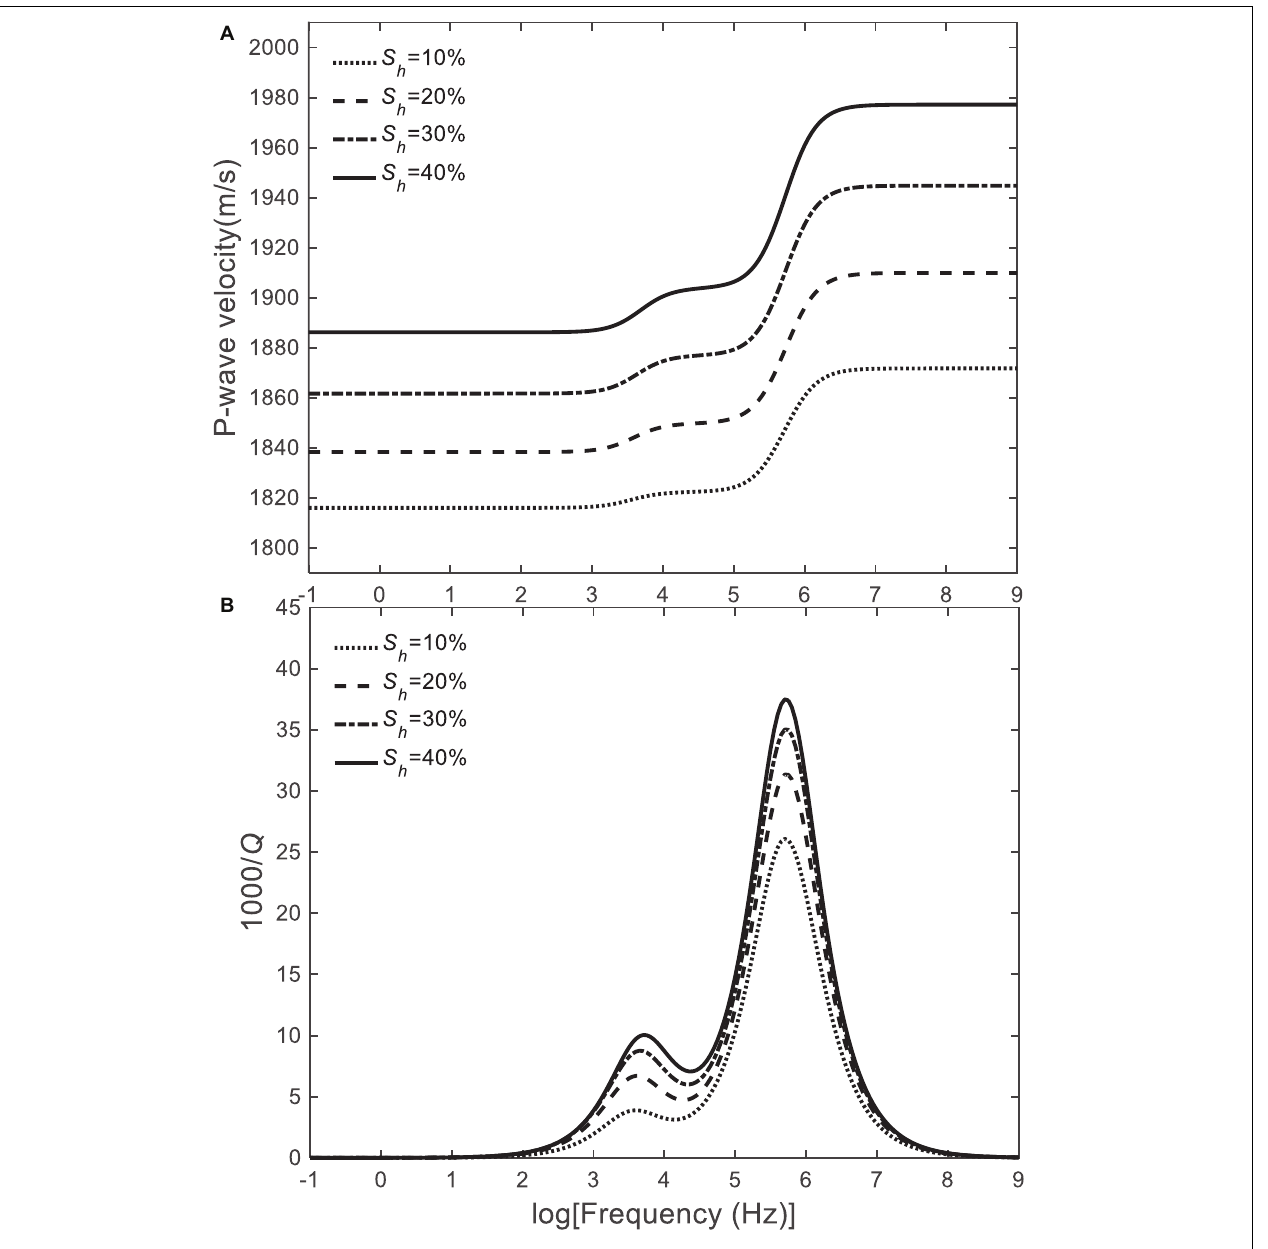
FIGURE 7 | Model 1. P-wave velocity (A) and dissipation factor (B) as a function of frequency for different hydrate contents. The inclusion radius is 1 cm and the porosity is 40%.